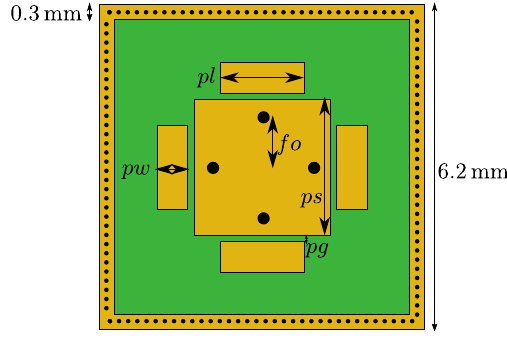
Figure 4. Antenna layout.